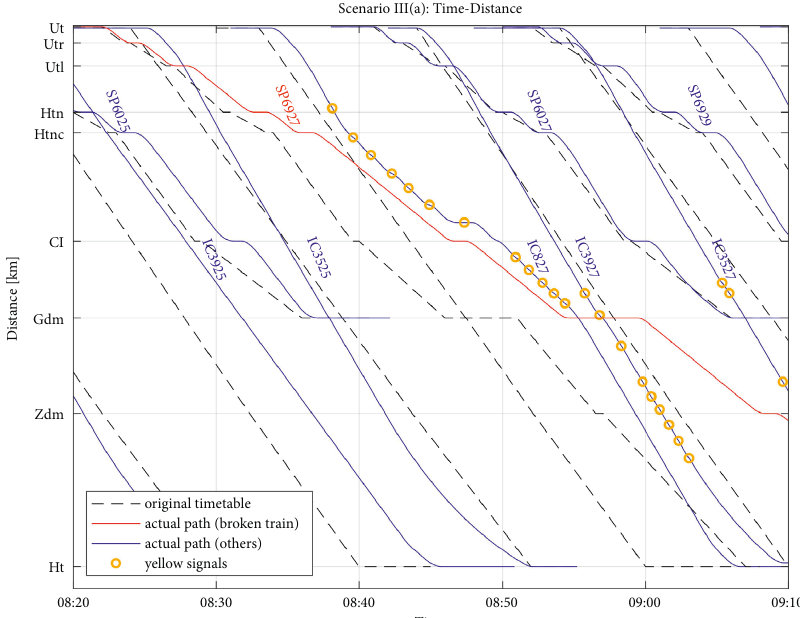
Figure 10: An example of time-distance paths in Scenario III (a).